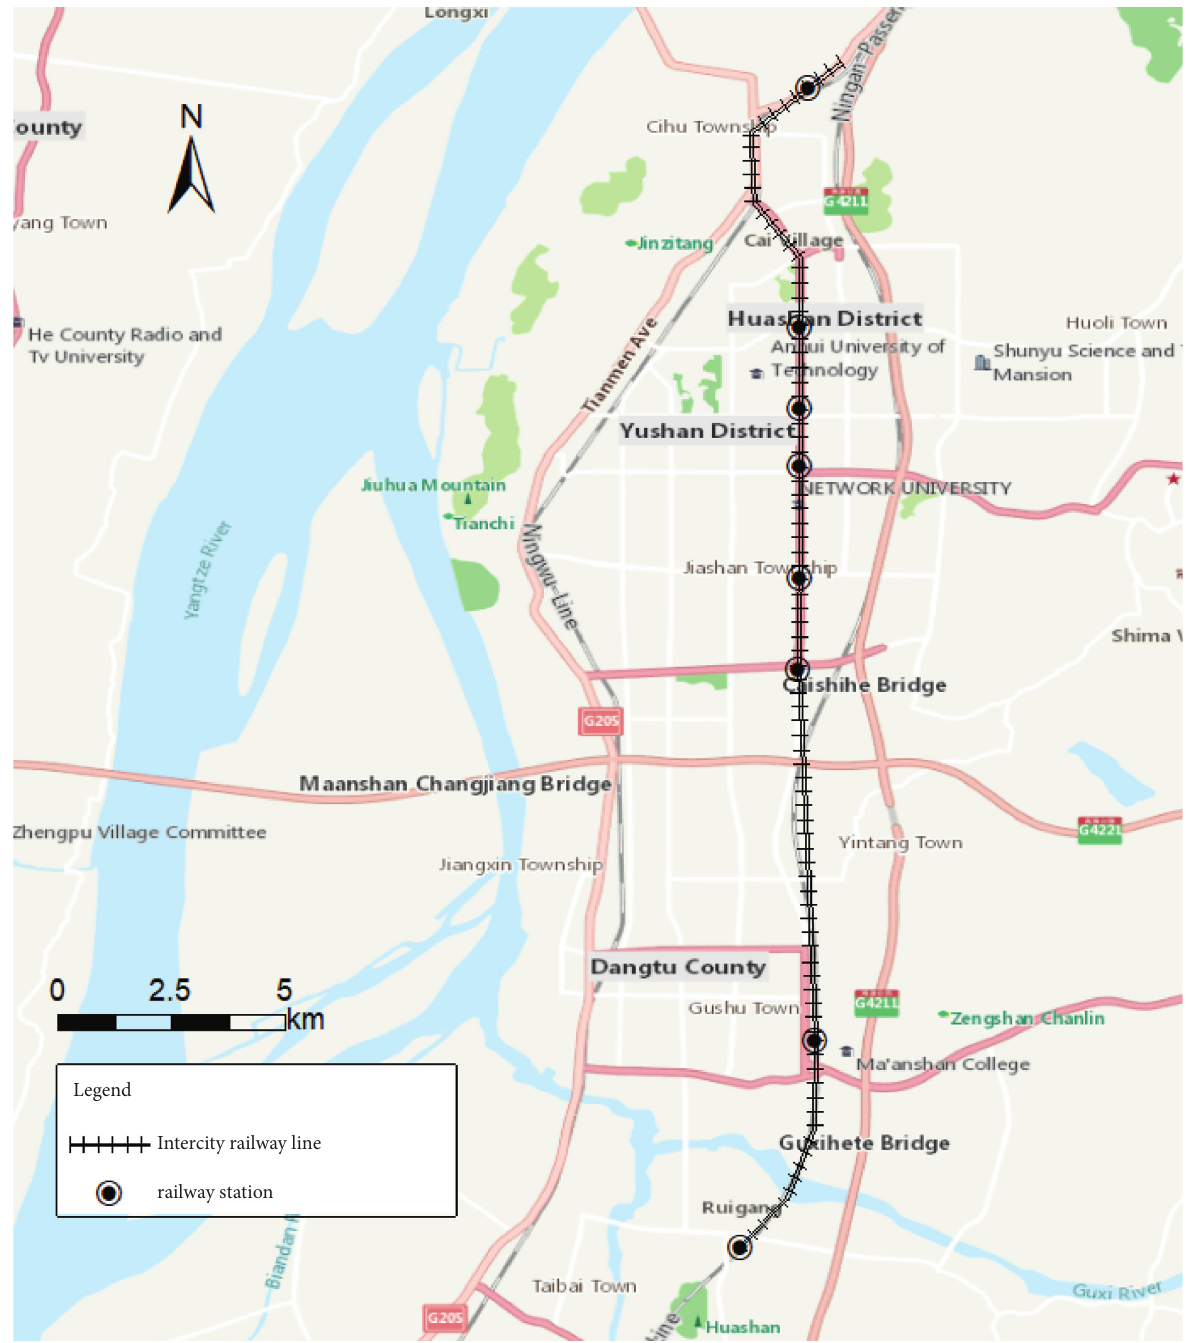
Figure 4: Ning-Ma intercity railway under